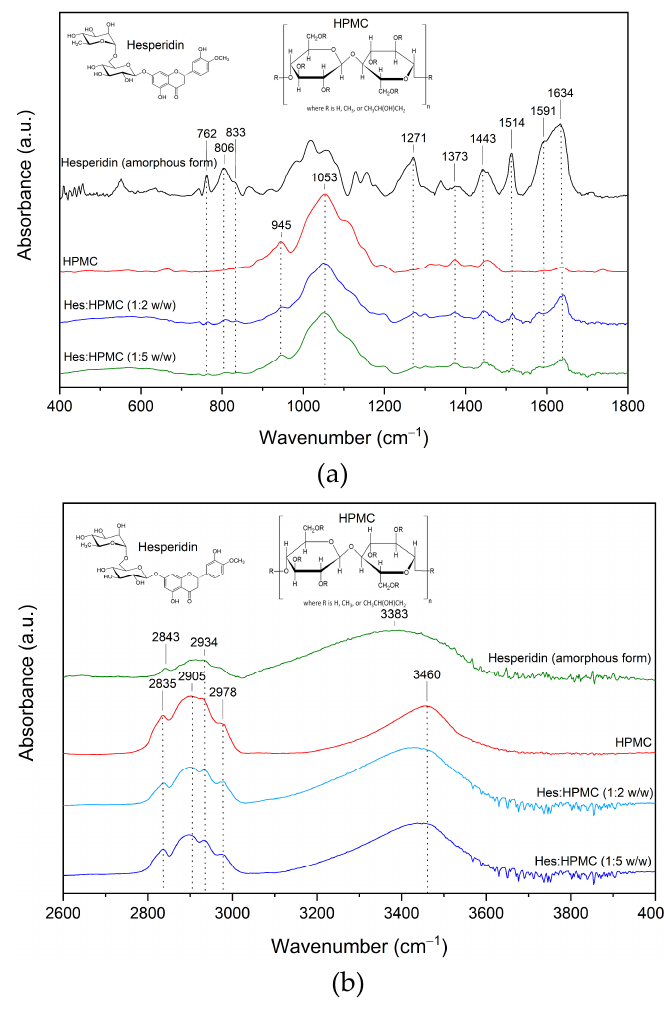
Figure 6. The FT-IR analysis—Hesperidin (amorphous form), HPMC, Hes:HPMC 1:2, Hes:HPMC 1:5; ( a ) range 400–1800 cm − 1 , ( b ) range 2600–4000 cm − 1 . Bands corresponding to HPMC [45–51] do not shift in the spectra of the systems,